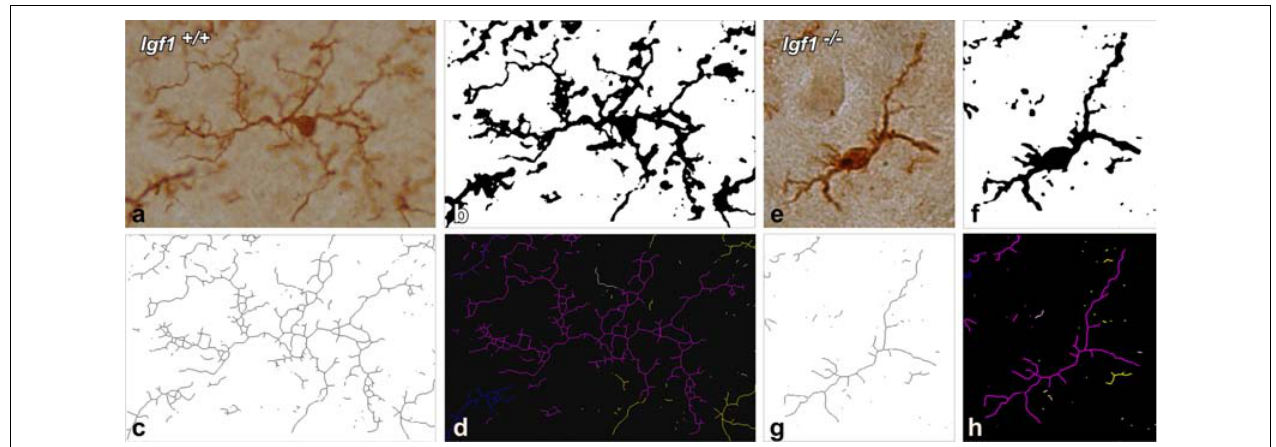
FIGURE 1 | Morphometric analysis of microglial branching. For the skeleton analysis, digital images of IBA1 immunostained cells were captured with a 40 × objective (A,E) , converted into binary images (B,F) and then skeletonized (C,G) . To evaluate microglial morphology parameters, skeletonized images were processed using the Analyze Skeleton plugin for Image J. Each glial cell is identified with a different color. The representative glia is shown in purple, and part of the skeleton of the other glial cells is shown in yellow, blue and white (D,H)